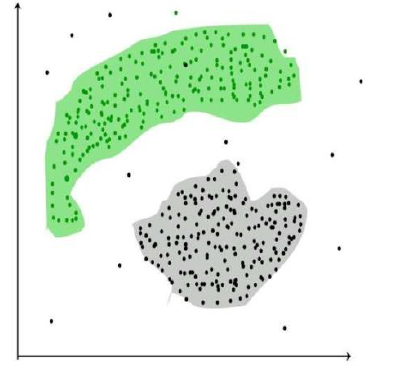
Figure 3. Linear-Separable Clusters [3]